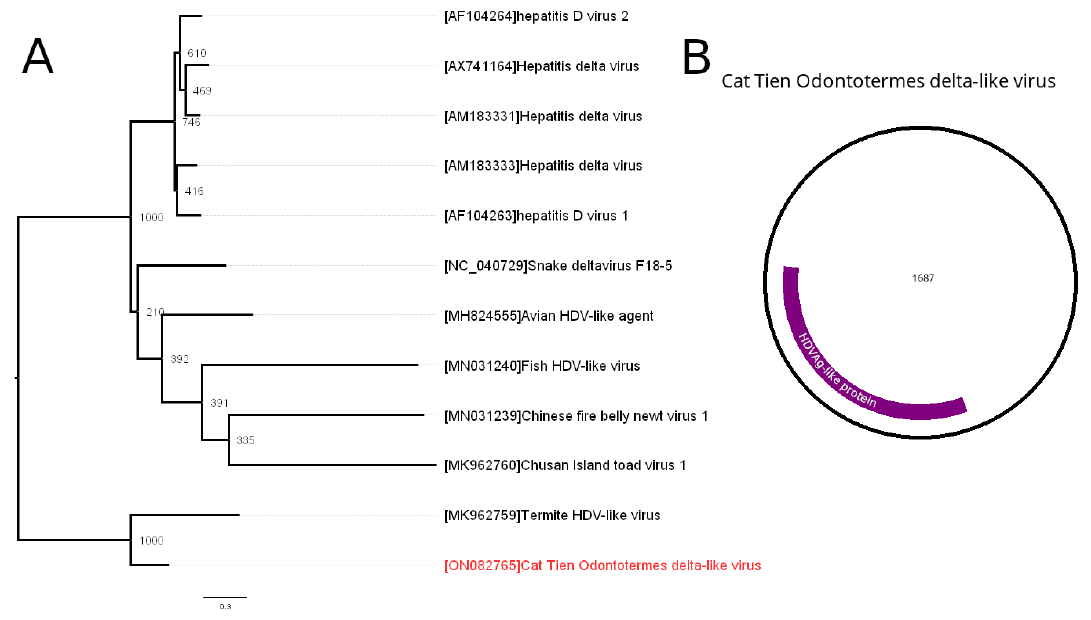
Figure 4. Phylogenetic relationships and genetic structure of the Cat Tien Odontotermes delta-like virus (СODLV). ( A ) Phylogenetic relationships of the СODLV. Analysis was performed using amino acid sequences of viral HDVAg, with 1000 bootstrap replicates. Bootstrap support values are shown for each node. Scale bar represents the number of amino acid substitutions per site. СODLV is marked red. ( B ) Scheme of the СODLV genome.